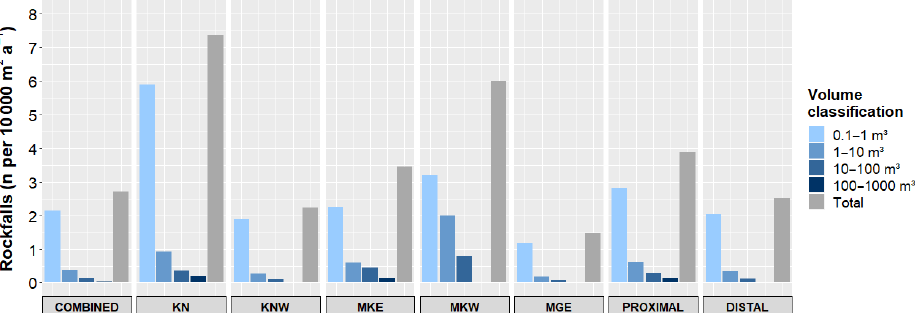
Figure 6. Normalized rockfall numbers ( n per 10000m 2 a − 1 ) for all monitored rockwalls. Rockfall frequency decreases exponentially with increasing rockfall size; 80% of all rockfalls rank in the smallest size class (0.1–1m 3